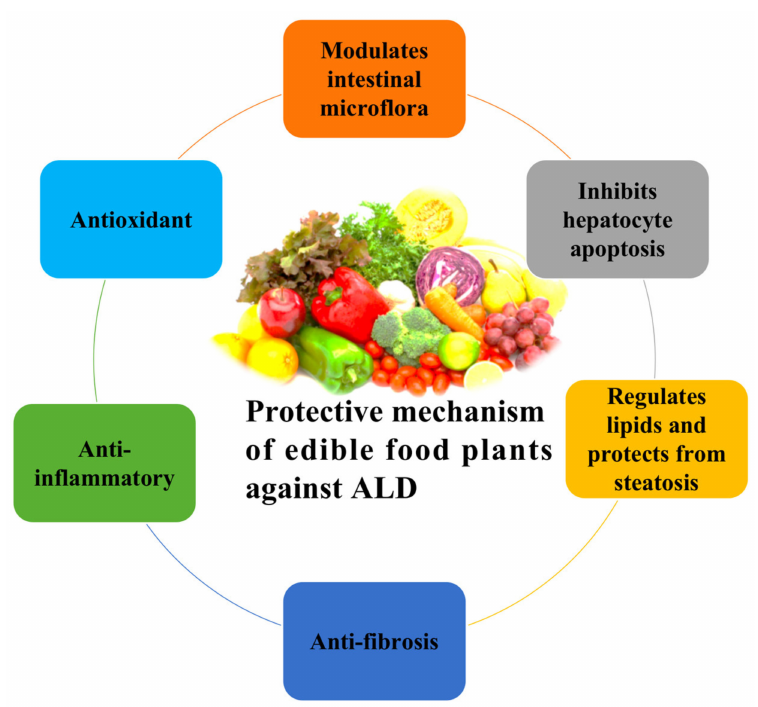
Figure 4. Protective effect of bioactive compounds and edible plant extract from